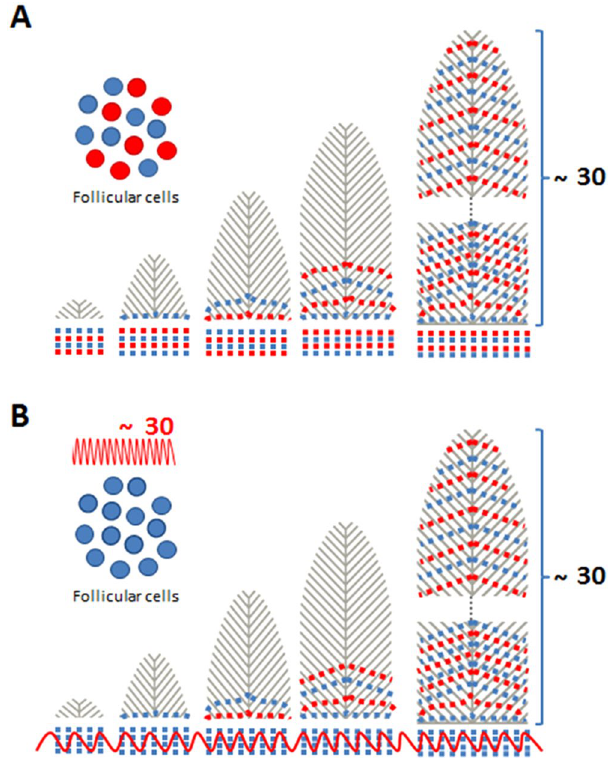
Figure 2. Models of pattern formation in feathers. ( A ) The observed Zn pattern formation (~30 regularly spaced deposits of Zn) may be the result of a pre-existing heterogeneity amongst feather stem cells with differential Zn uptake giving rise to a mosaic with a subsequent Zn pattern formation. ( B ) The absence of any ultrastructural differences (see Fig. 3) gives rise to a speculative, alternative explanation: The number of alternate lines of high and low Zn (~30) approximates the estimated overall period of growth, i.e. ~30 days. The Zn pattern formation might thus reflect diurnal oscillation in systemic Zn levels.